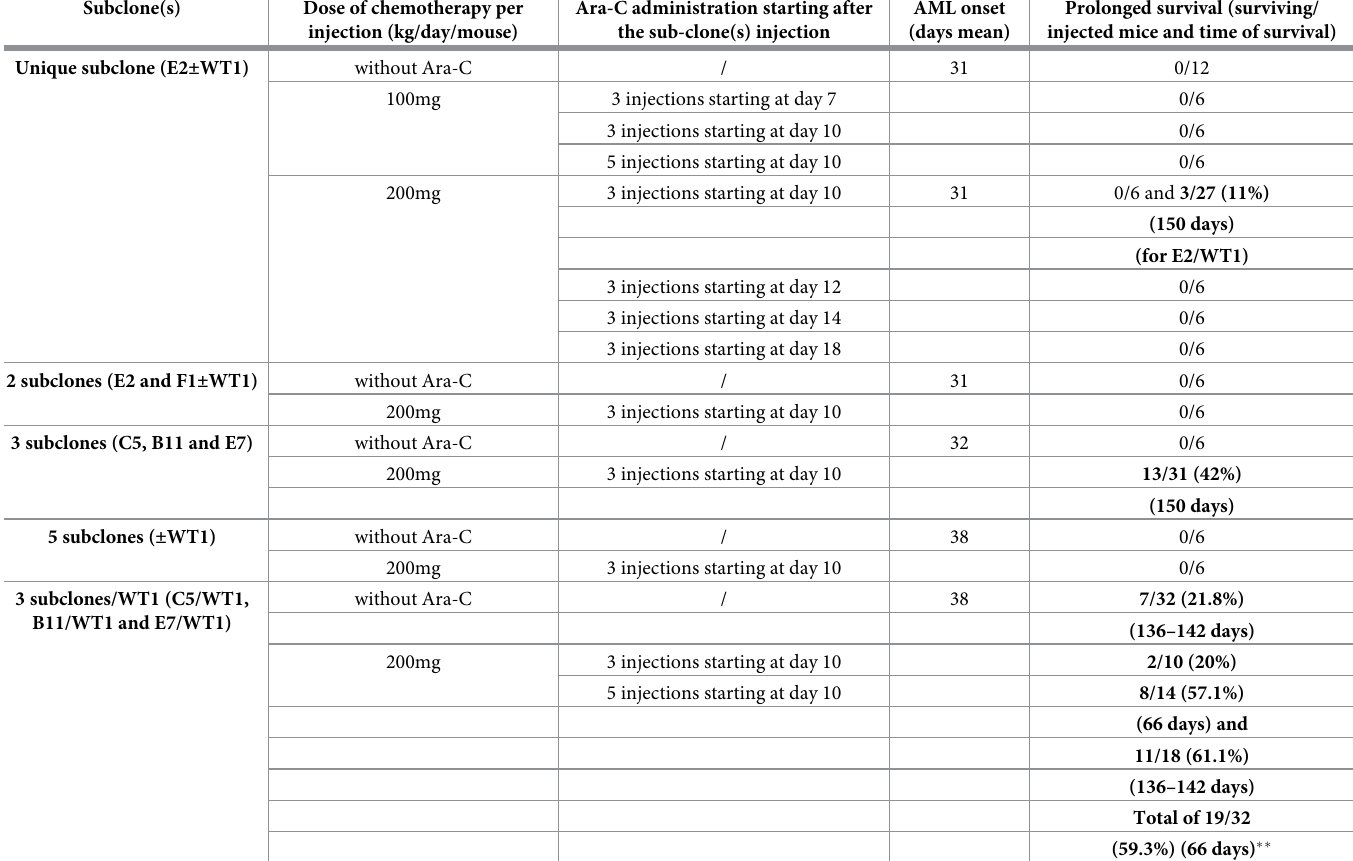
Table 1. Leukemic sub-clone(s) injections and cytarabine (Ara-C) administration protocols (doses and kinetics) for AML-bearing mice survival optimization.